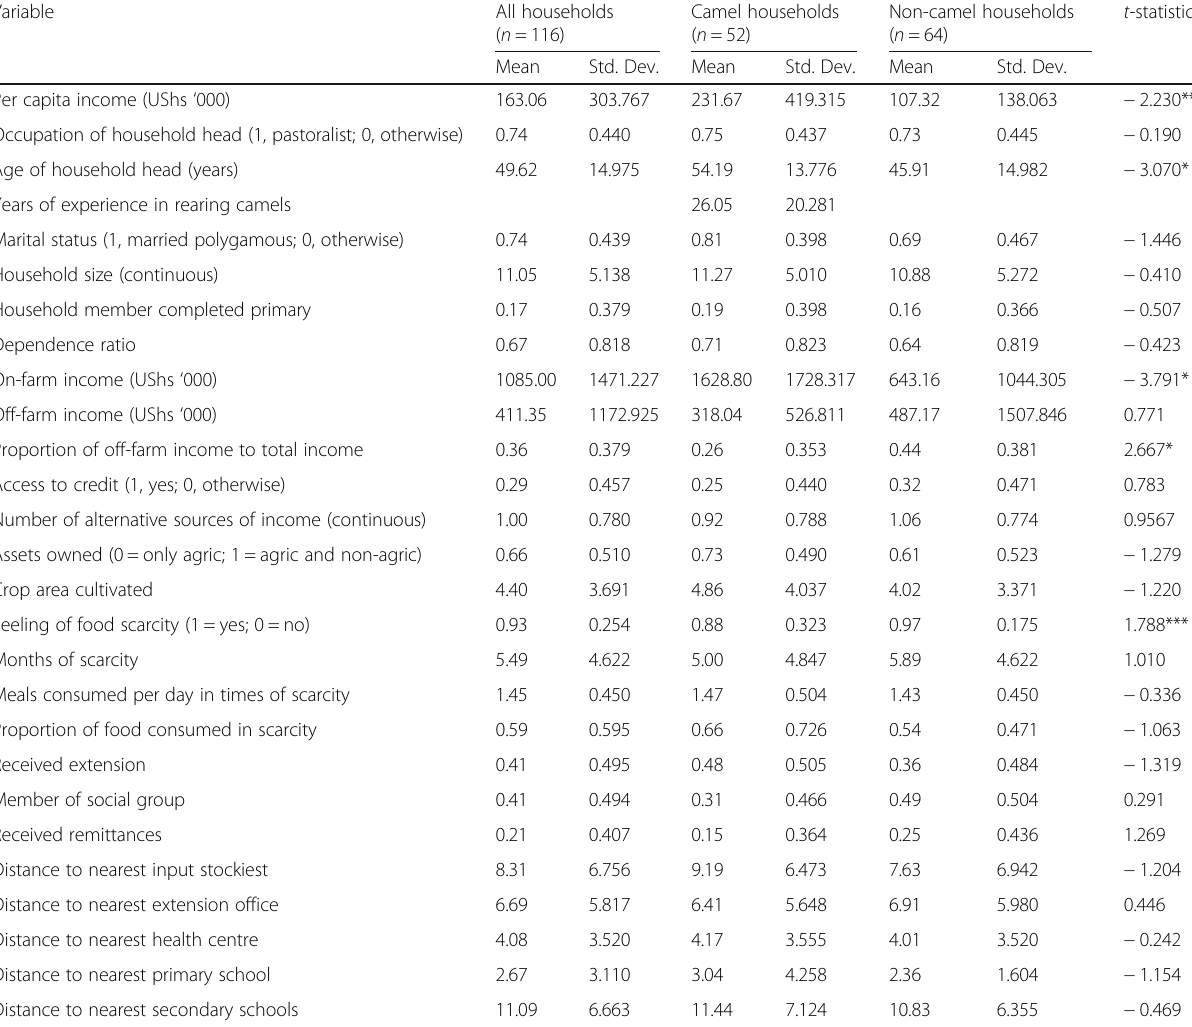
Table 1 Socio-economic and demographic characteristics of the surveyed households Variable All households